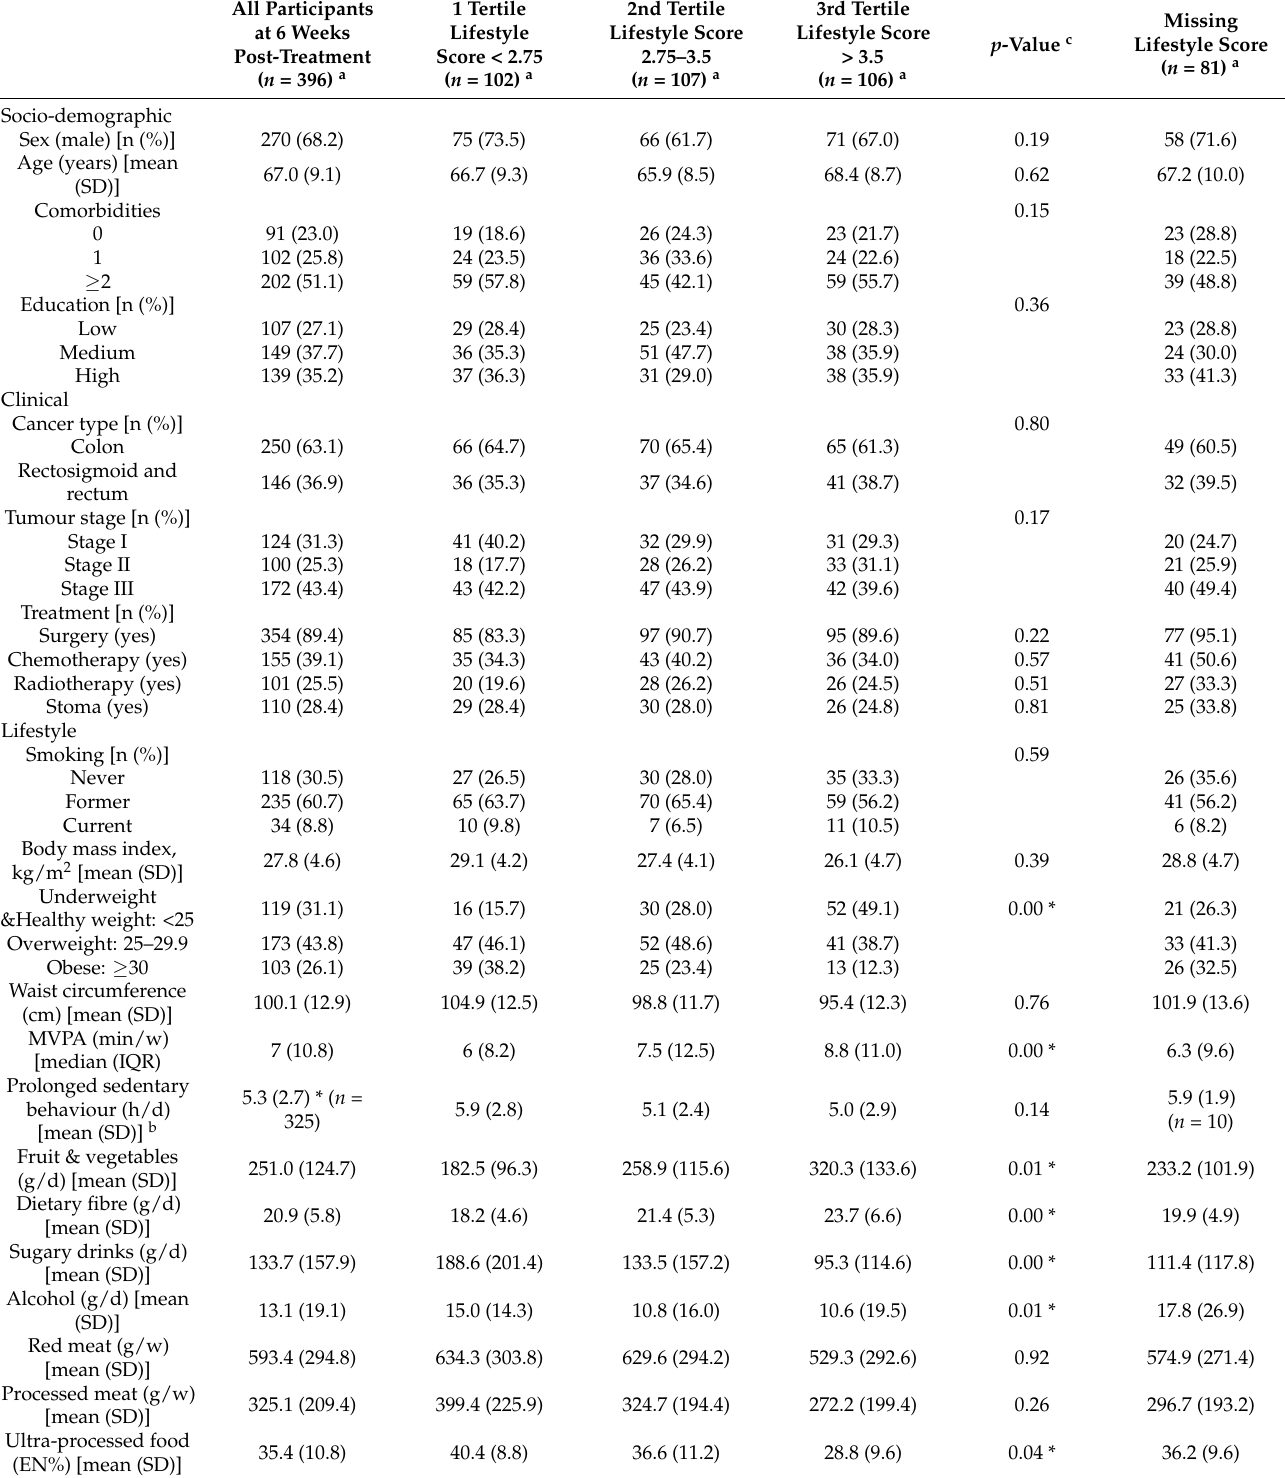
Table 2. Demographic, lifestyle, and clinical characteristics of colorectal cancer survivors, by cate- gories of the lifestyle score (with tertiles used as cut-off) and compared to participants who did not have a lifestyle score at 6